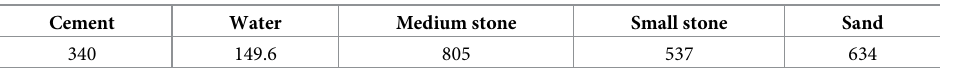
Table 2. Laboratory mix